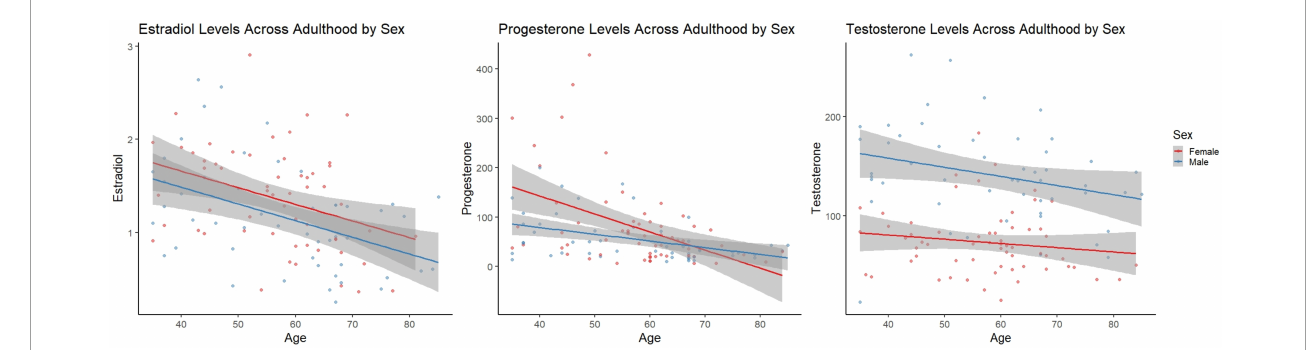
FIGURE2 Linear scatter plots demonstrate estradiol levels in females and males across adulthood. The gray superimposed on each colored line depicts the 95% confidence interval in each sex. Estradiol levels (left) were not significantly different by sex when accounting for age ( p = 0.071). Progesterone levels (middle) were not significantly different by sex when accounting for age ( p = 0.073). Testosterone levels (right) were significantly different by sex when accounting for age ( p < 0.001).